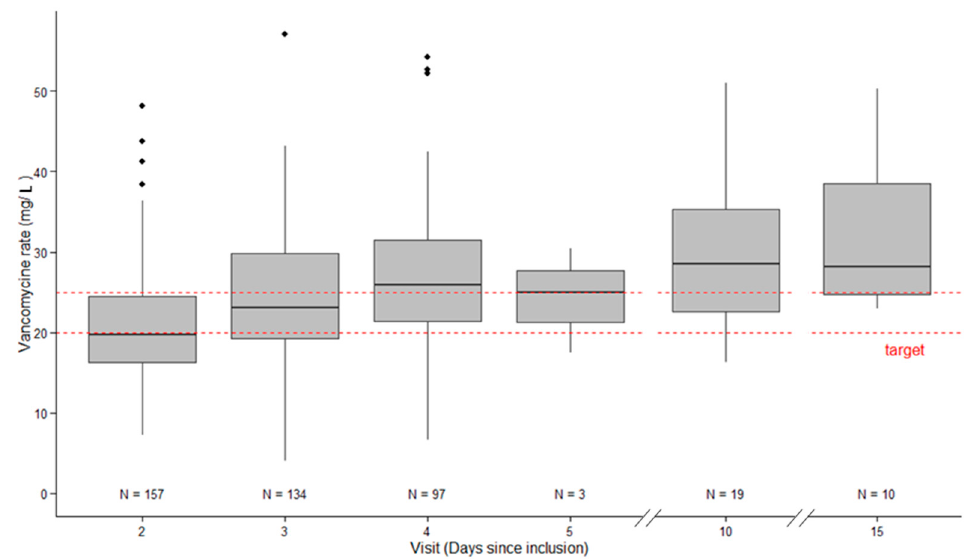
Figure 2. Vancomycin serum concentration over time (D2, D3, D4, D10, and D15).